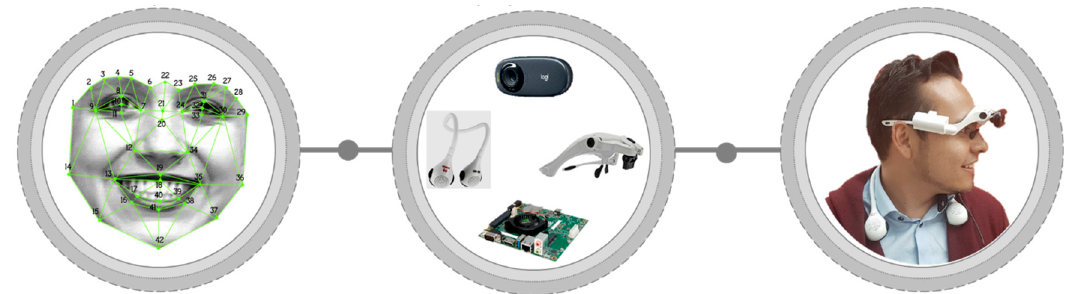
Figure 1. Processes for the development of the face recognition system for people with visual disabilities, a) face recognition under different facial expressions, b) implement the devices and adapt them to people with disabilities, c) system integration.